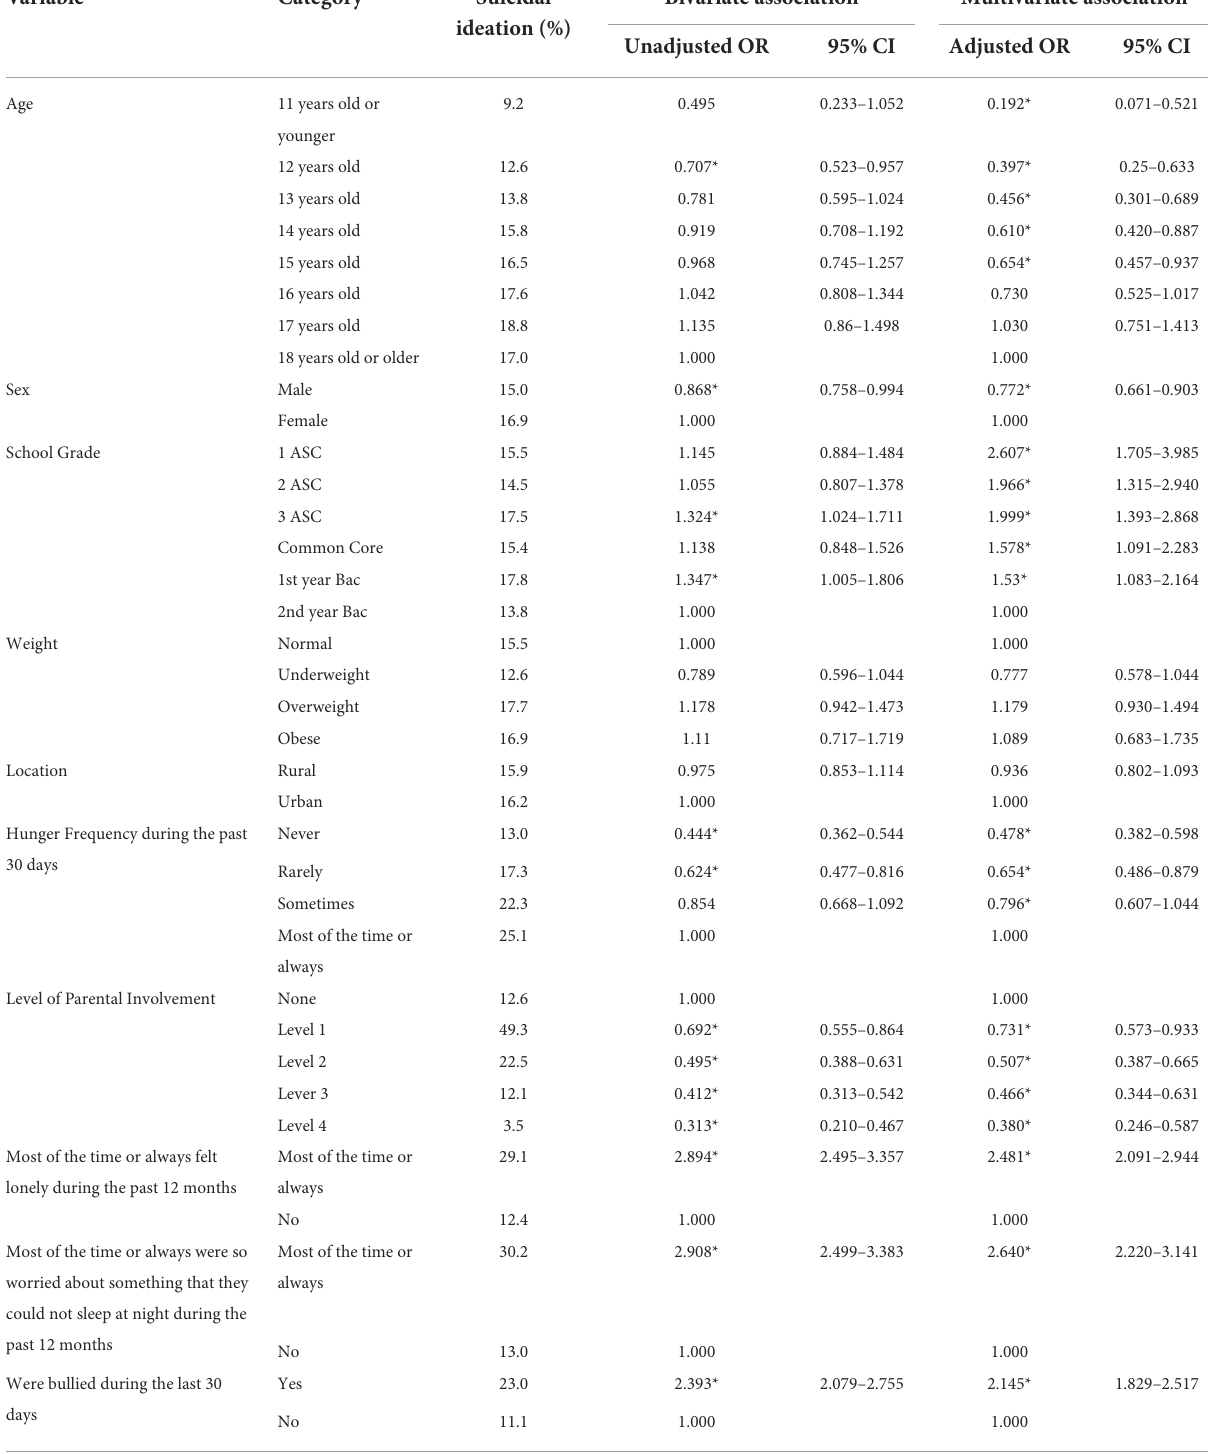
TABLE 3 Chi-squared and regression analysis of demographics and risk factors associated with suicidal ideation. Variable Category Suicidal Bivariate association Multivariate association ideation (%) Unadjusted OR 95% CI Adjusted